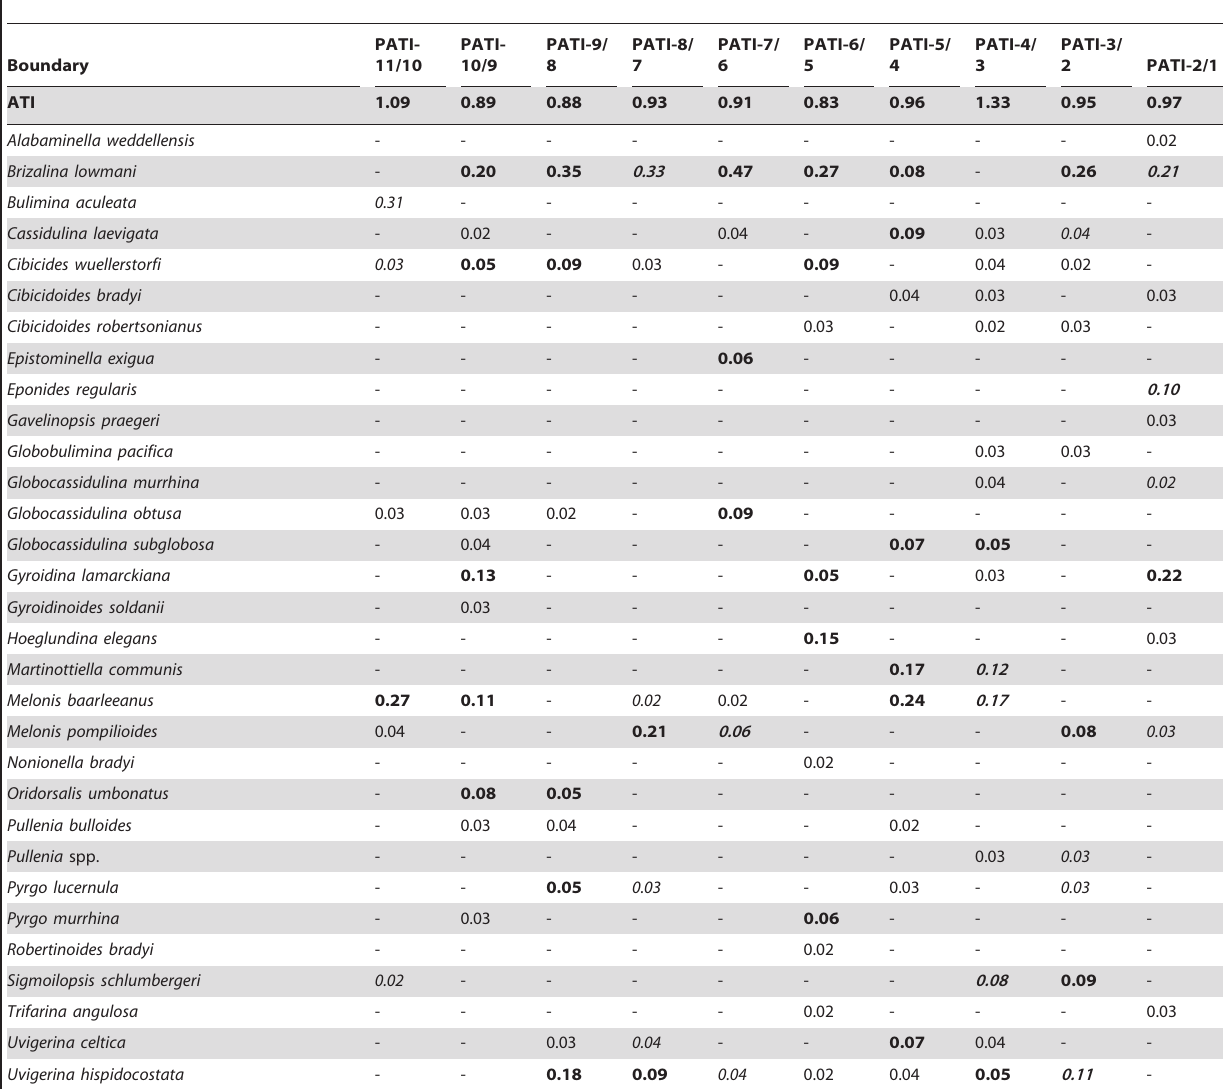
Table 1. Partial conditioned-on-boundary index (CoBI p ) for peak-bounded ATI s (PATI-) intervals in the Upper Quaternary in ODP Hole 994C, Blake